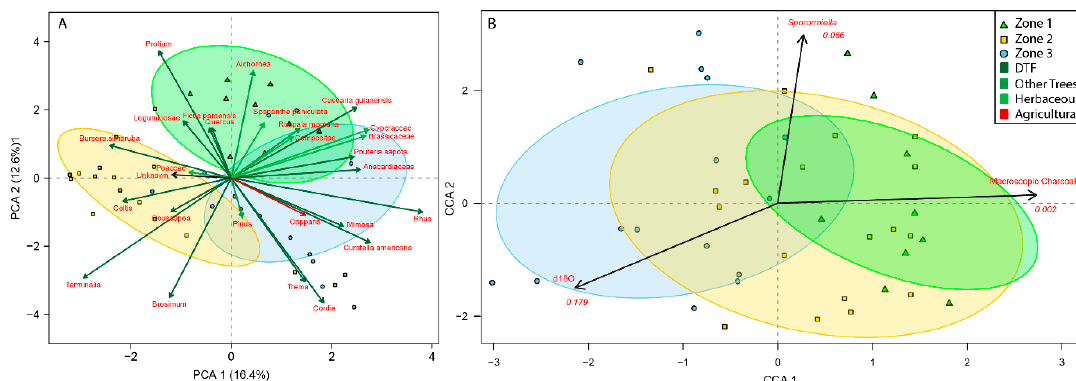
Figure 7. Principal component analysis of the palynological assemblage ( A ) Canonical correspondence analysis of the palynological assemblage ( B ) Zones derived from the broken stick model represented by ellipses at a confidence of 95%. Zone 1 = green triangles; Zone 2 = yellow squares; Zone 3 = blue circles.